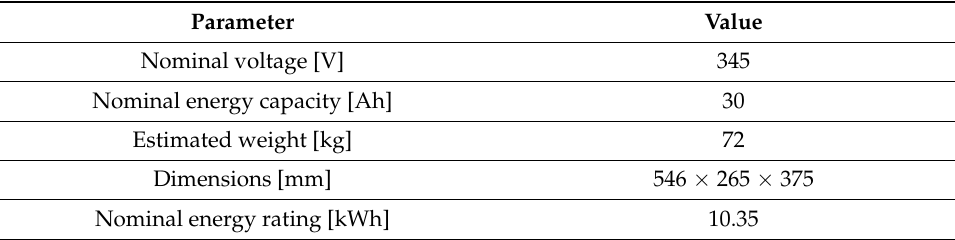
Table 3. The battery pack parameters